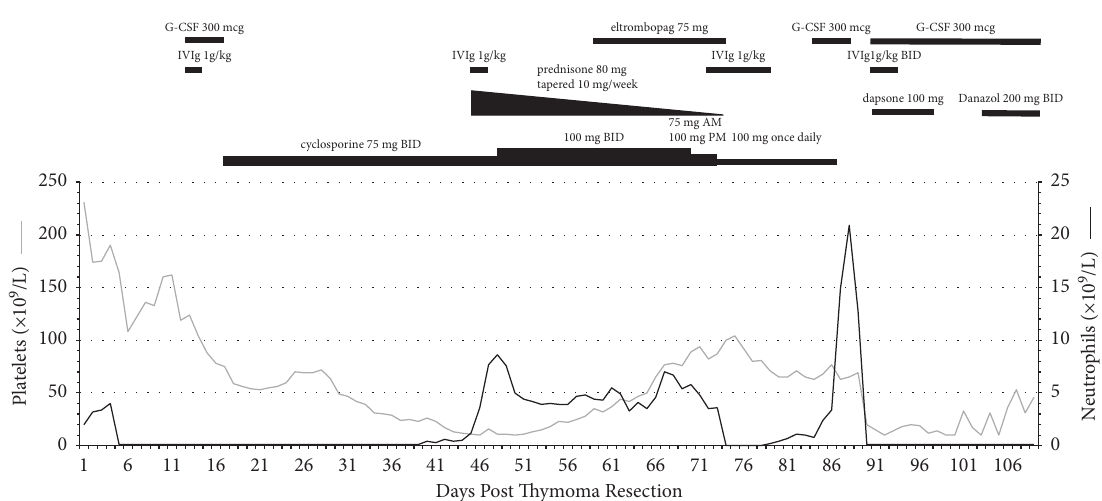
Figure 2: Trends in neutrophil and platelet counts following thymoma resection.